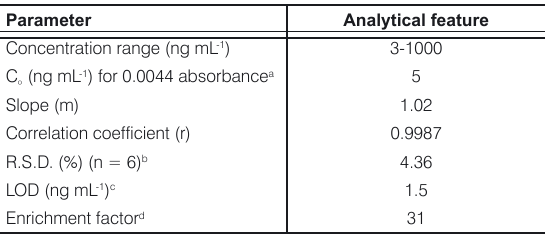
Table 1. Analytical characteristics of the